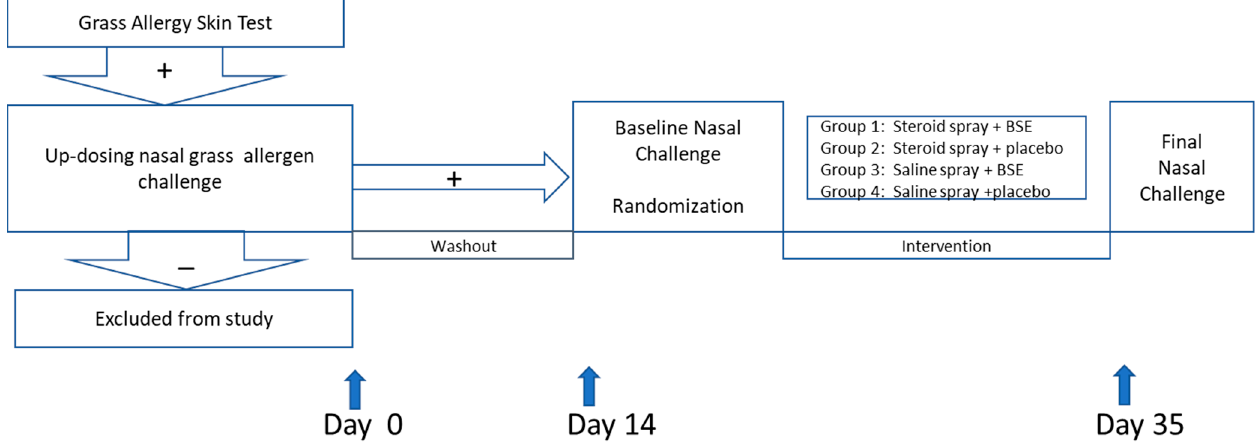
Figure 1. Overview of Study Protocol. Subjects were recruited based on clinical symptoms consistent with allergic rhinitis to grass pollen and verified with skin testing. If subject tested positive to grass pollen, they proceeded to an up-dosing nasal challenge for confirmation. Subjects who had positive challenge test returned in 2 weeks for the baseline nasal challenge and randomization, then returned 3 weeks after visit 2 for final nasal challenge.